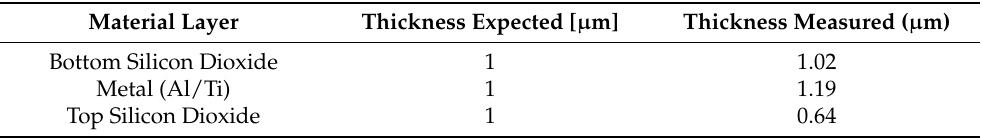
Table 1. Material layers thickness of the undercarriage